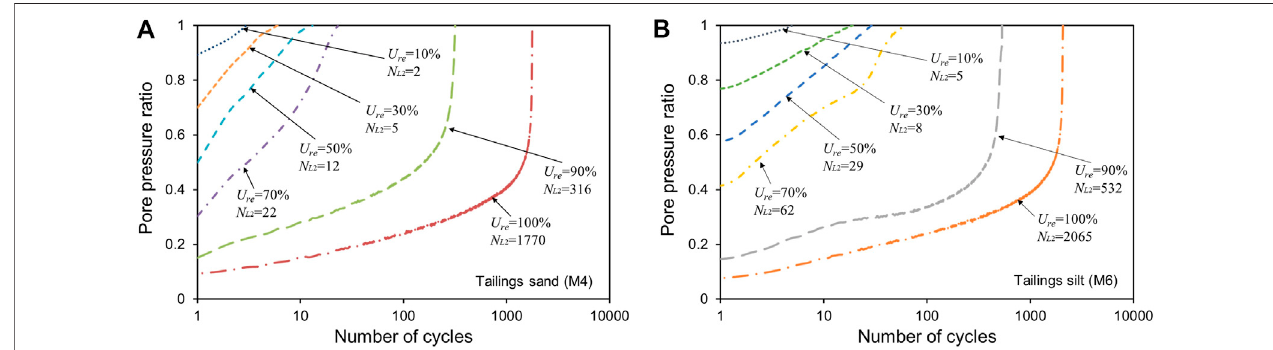
FIGURE 7 | Relationship between the excess pore water pressure ratio and number of cycles of tailings after liquefaction with different reconsolidation degrees ( U re ): (A) tailing sand (M4) and (B) tailing silt (M6).